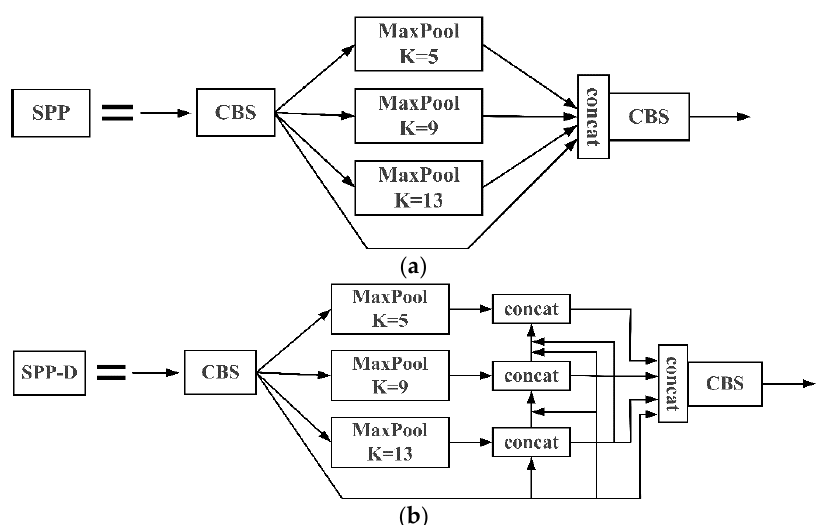
Figure 7. Improved before and after module structure. ( a ) SPP module. ( b ) Improved SPP-D module.